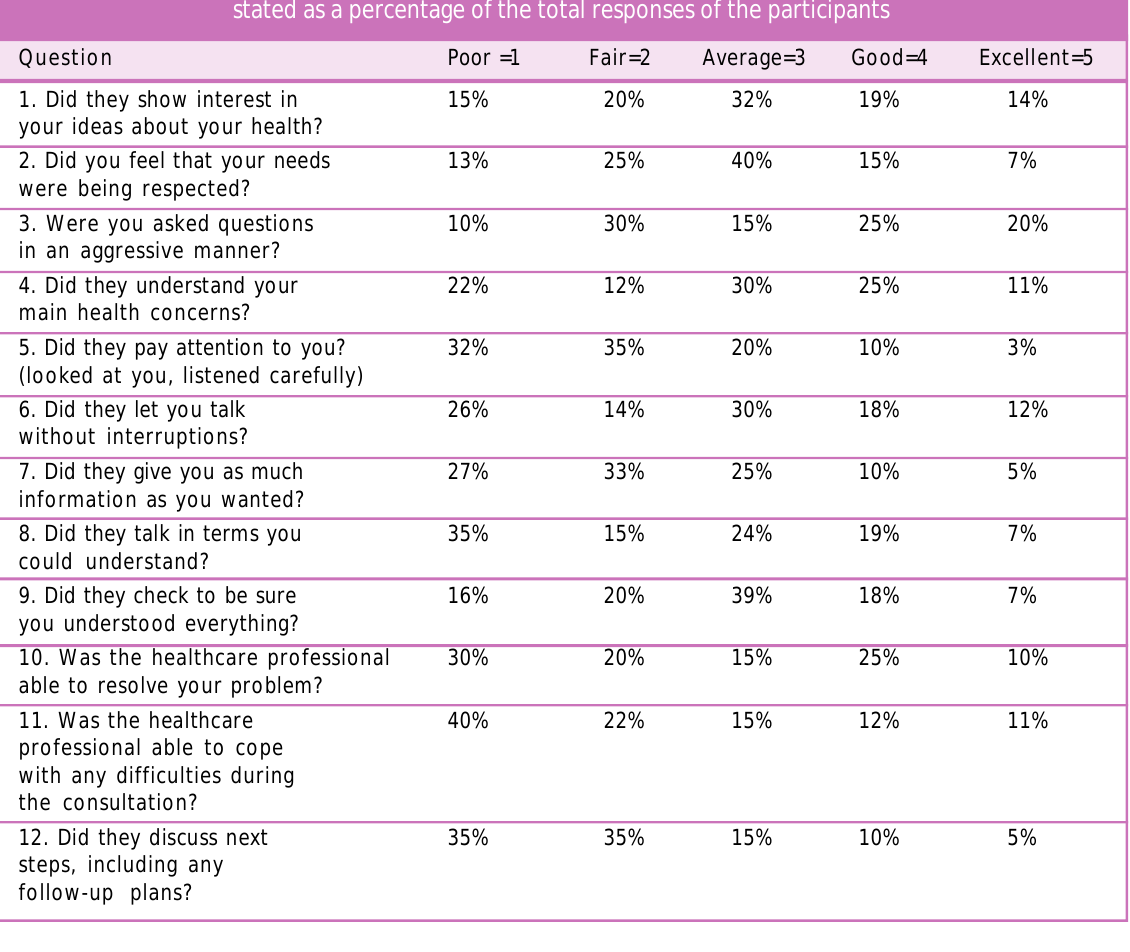
Table 1. Responses for questions in the questionnaire regarding communication,